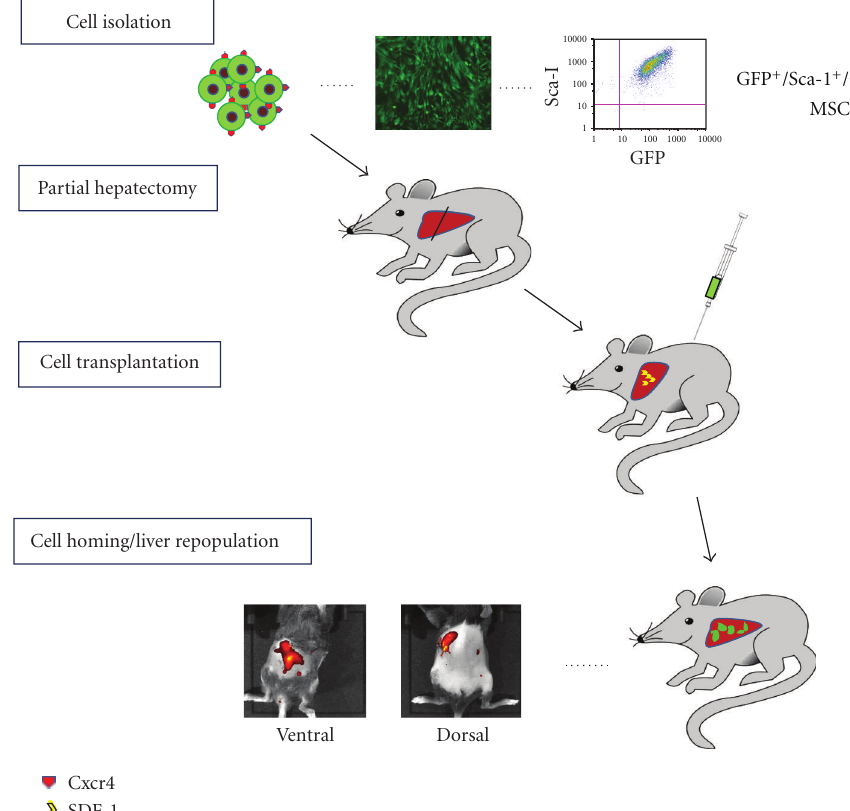
Figure 8: Schematic depiction of liver targeting of MSCs through intrasplenic injection. GFP-transgenic mouse bone marrow derived MSCs, which are positive for GFP, Sca-1, Cxcr4, and Abcc6 , were injected through spleen 24 hours after partial hepatecotomy inducing release of SDF-1, a ligand of Cxcr4. The presence of transplanted cells was observed by a live imaging system at day 7 posttransplantation through ventral view (liver) and dorsal view